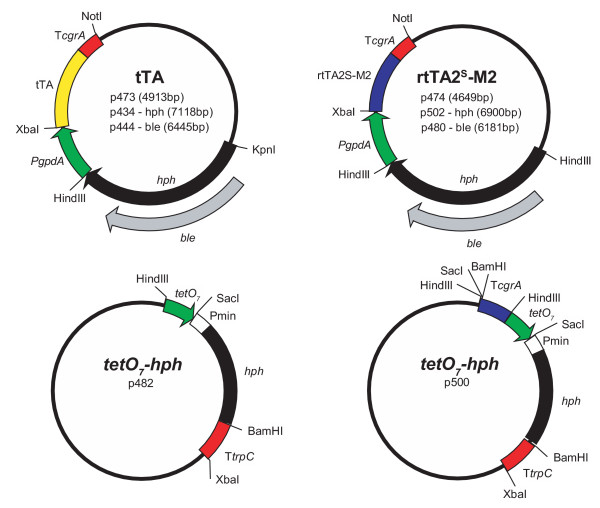
Schematic representation of plasmid constructions. The tTA gene is expressed from the A. nidulans promoter in three plasmids: p473 (no selection), p434 (hygromycin resistance encoded by hph) and p444 (phleomycin resistance encoded by ble). The rtTA2S-M2 gene is expressed from the A. nidulans gpdA promoter in p474 (no selection), p502 (hygromycin selection encoded by hph) and p480 (phleomycin resistance encoded by ble). Two versions of the tetO7-hph reporter construct are shown below. Plasmid p482 contains seven copies of tetO, a 175 bp minimal gpdA promoter (Pmin), and the hph gene encoding resistance to hygromycin. Plasmid p500 contains the same components, with the addition of a 280 bp fragment of the A. fumigatus cgrA terminator region upstream of the tetO7 promoter to reduce read-through from flanking sequences. All plasmids have been deposited in the Fungal Genetics Stock Center for distribution.